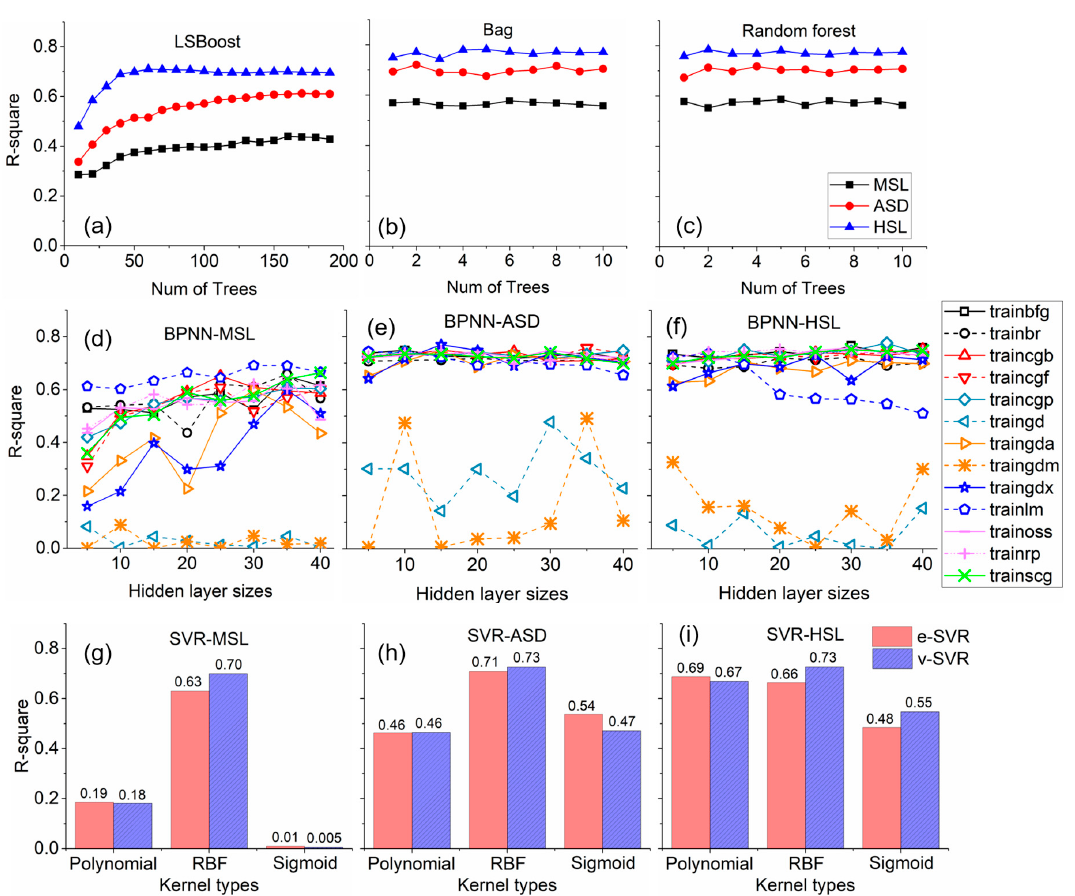
Figure 5. The estimation R 2 of LNC using reflectance spectra from MSL, ASD, and HSL with five nonlinear regression algorithms: least squares boosting (LSBoost, ( a )), bagging (Bag, ( b )), random forest (RF, ( c )), back-propagation neural network (BPNN, ( d – f ) are the results using spectra from MSL, ASD, HSL, respectively), and support vector machine (SVR, ( g – i ) are the results using spectra from MSL, ASD, HSL, respectively). The performance of each algorithm with different parameters (different number of base learners for LSBoost, Bag, and RF. varying hidden layer sizes using different transfer function for BPNN, and two types of SVR: e-SVR and v-SVR) were shown. Table 1. Regression performance of the six algorithms with optimal parameters (PLSR, LSBoost, Bag, RF, BPNN, and SVR; unit of RMSE: mg/g).